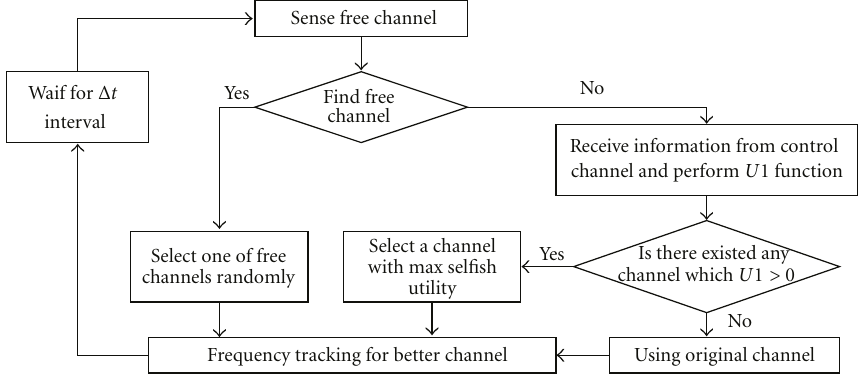
Figure 4: The Work Flow of Selfish Spectrum Sharing.